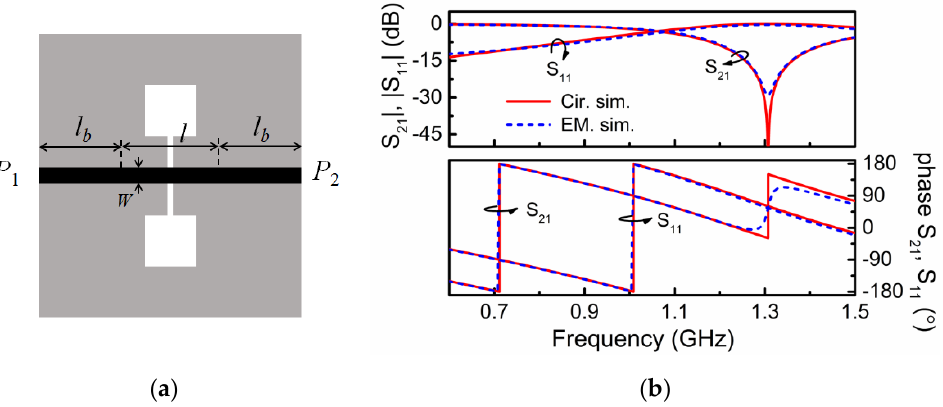
Figure 3. Layout ( a ) and frequency response ( b ) of the considered DB-DGS. DB-DGS dimensions are: length of the narrow slot 2 l = 24 mm, width of the slot 0.2 mm, side length of the square apertures 12 mm. The electromagnetic simulations are lossless.